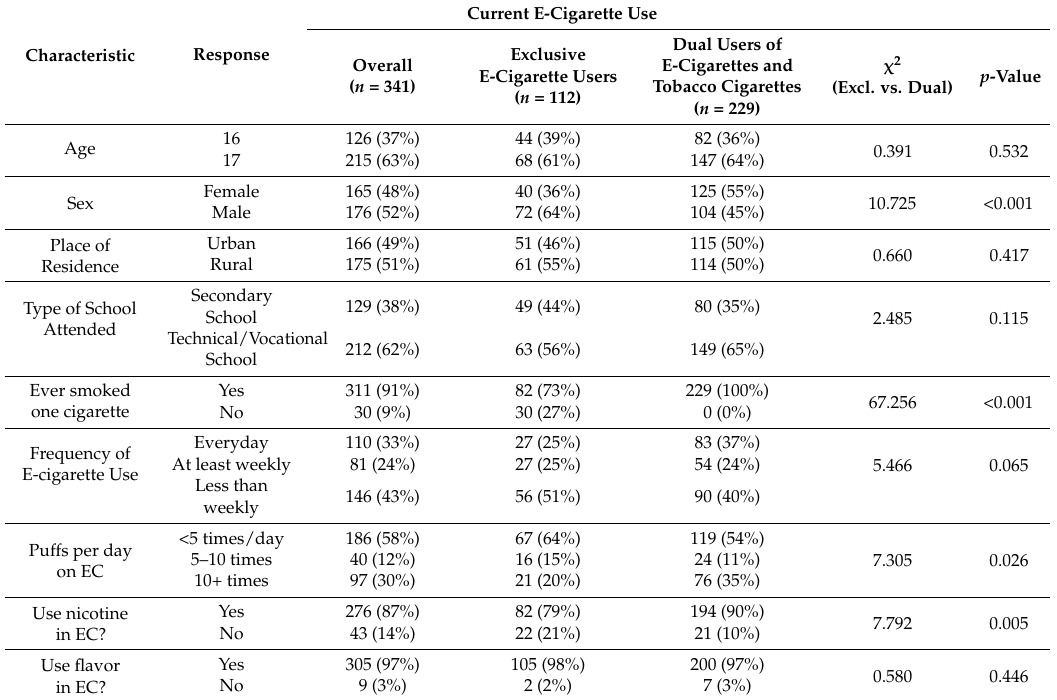
Table 1. Participant demographics, e-cigarette use patterns, and e-cigarette product characteristics